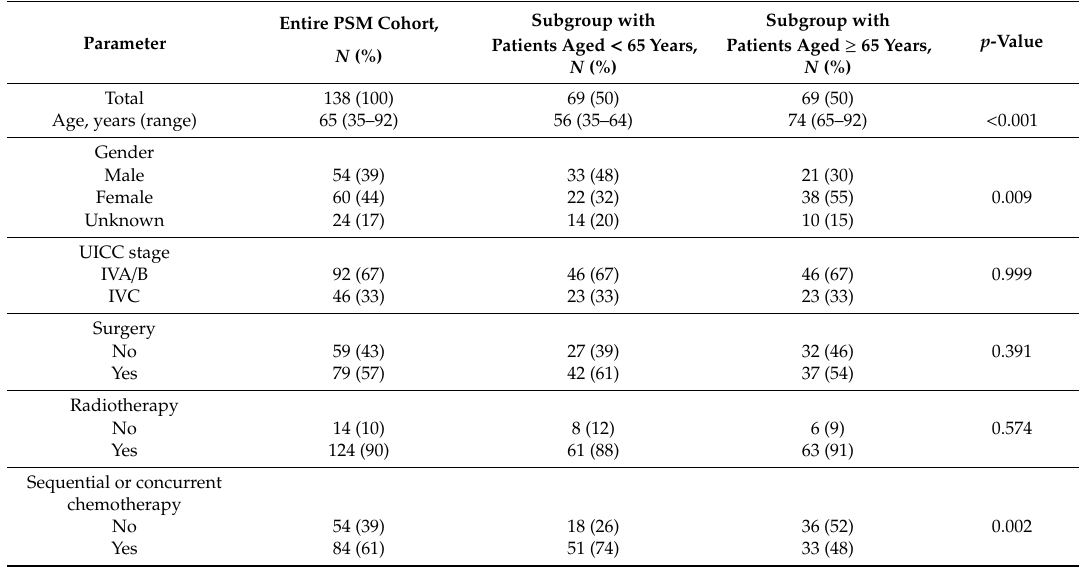
Table 3. Patient and treatment characteristics of the propensity score cohort.